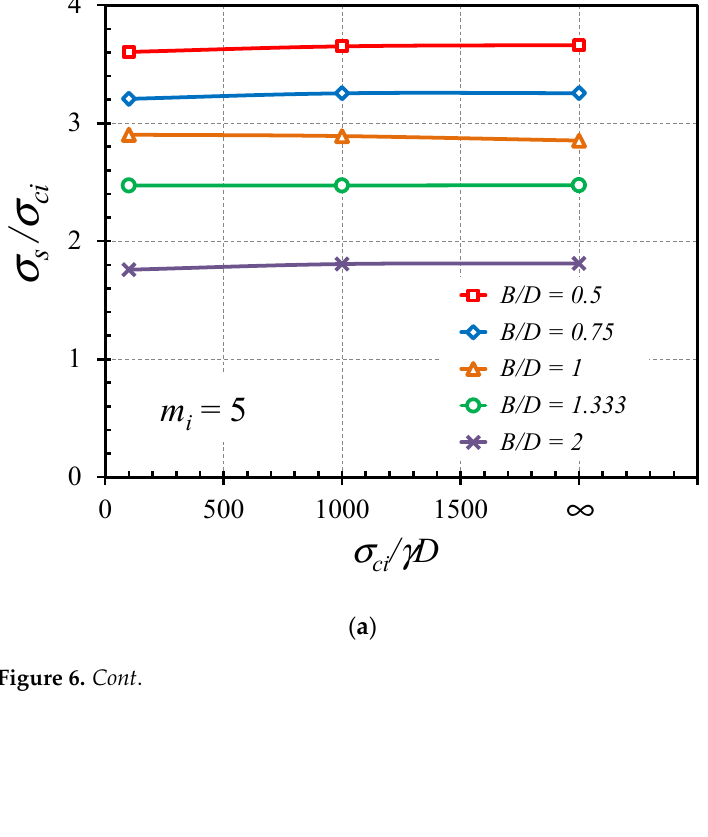
( b ) Figure 6. Impact of σ ci / γ D on σ s / σ ci of horseshoe tunnels with C / D = 3 and GSI = 80: ( a ) m i = 5 and ( b ) m i = 30.